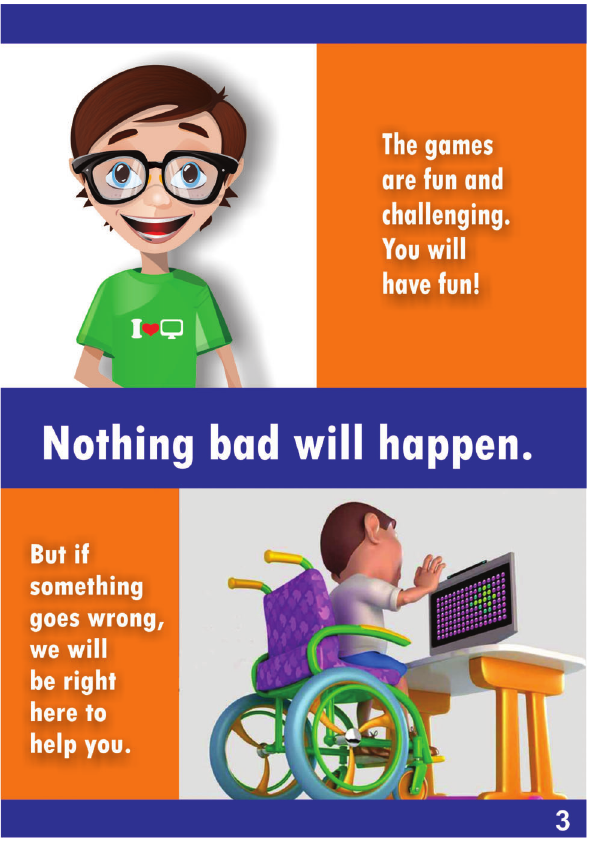
Figure 3D - Model of assent - Part